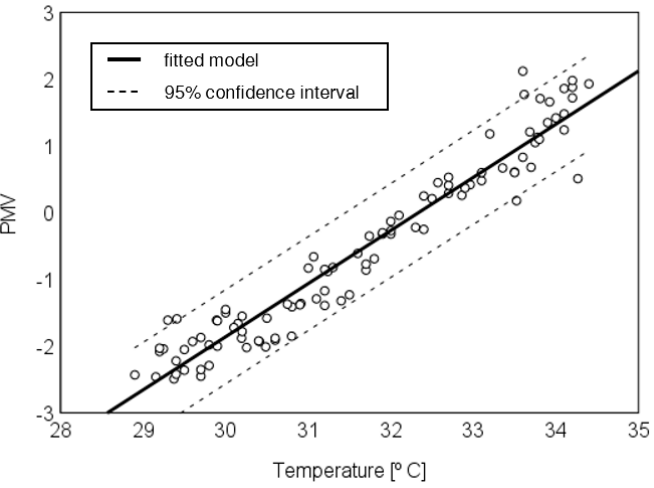
Figure 12. PMV prediction model as a function of the average face temperature.